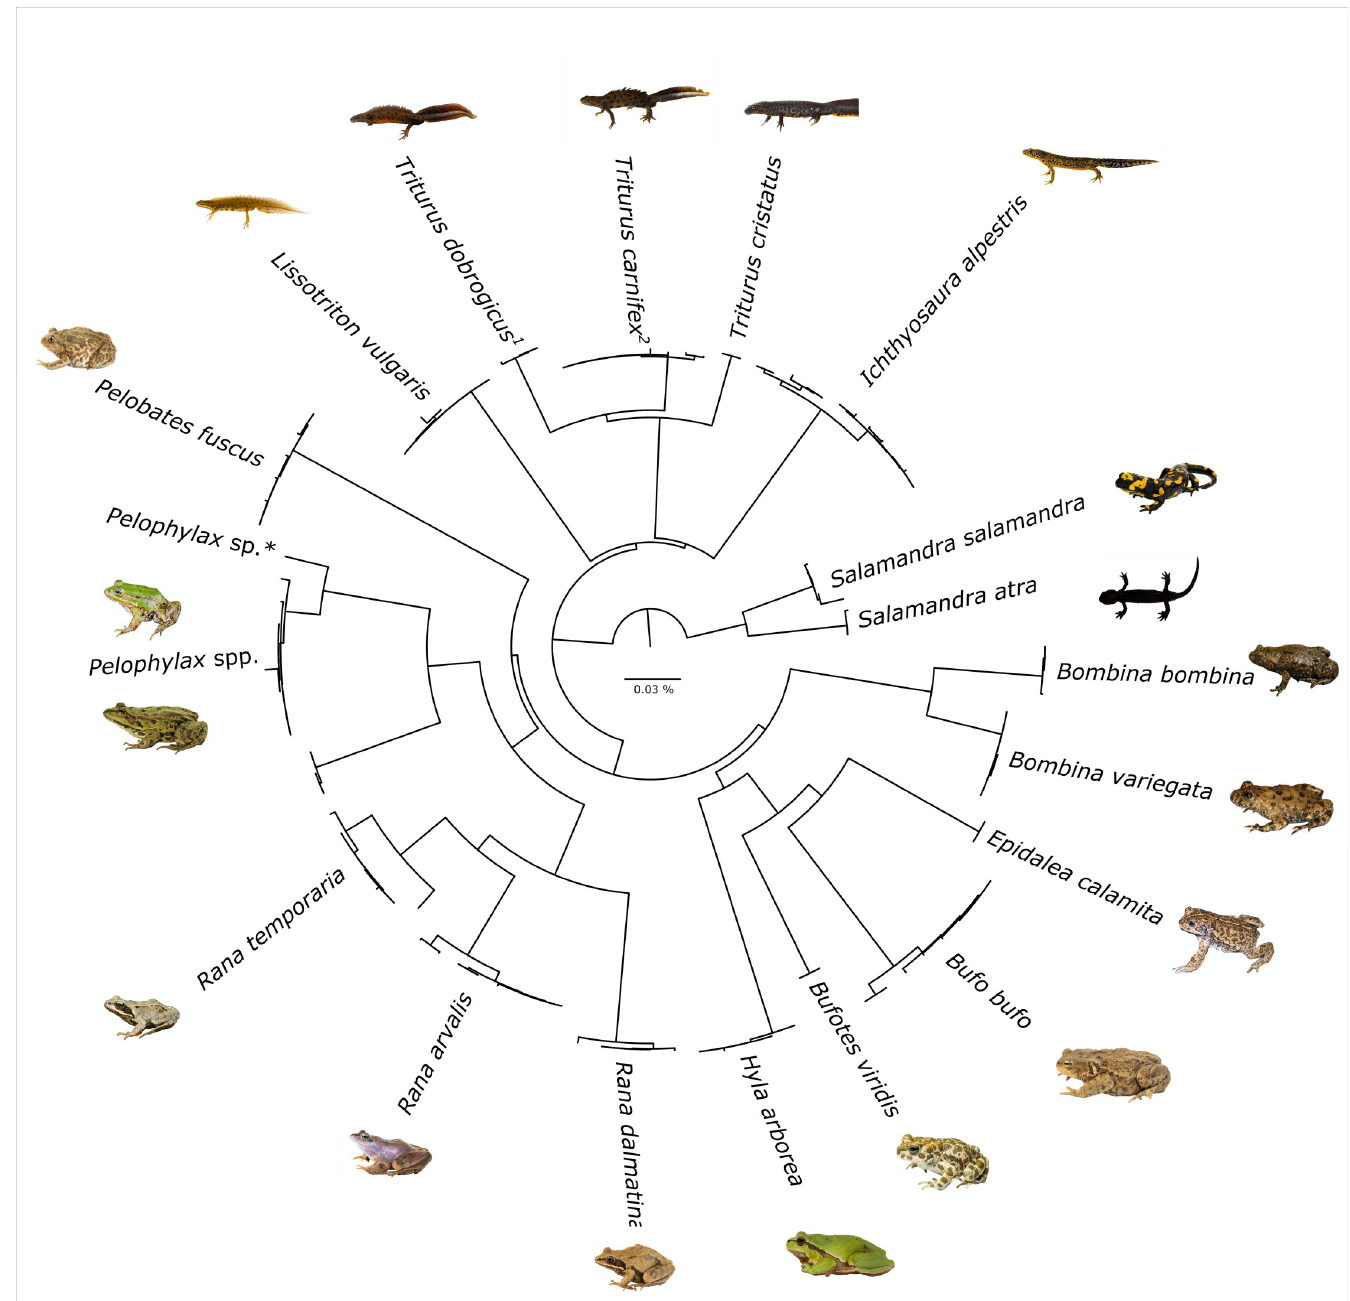
Fig 1. NJ tree of Austrian amphibians based on K2P distances. The tree was inferred with the “Taxon ID Tree” tool implemented in BOLD and visualized in FigTree v1.4.2 (http://tree.bio.ed.ac.uk/software/figtree/). � indicates an Austrian water frog sample showing genetic signatures of the Italian water frog ( P . bergeri ). 1 indicates the T . dobrogicus clade, which contains one sample identified as T . carnifex . 2 marks the T . carnifex clade, which also holds one T . cristatus